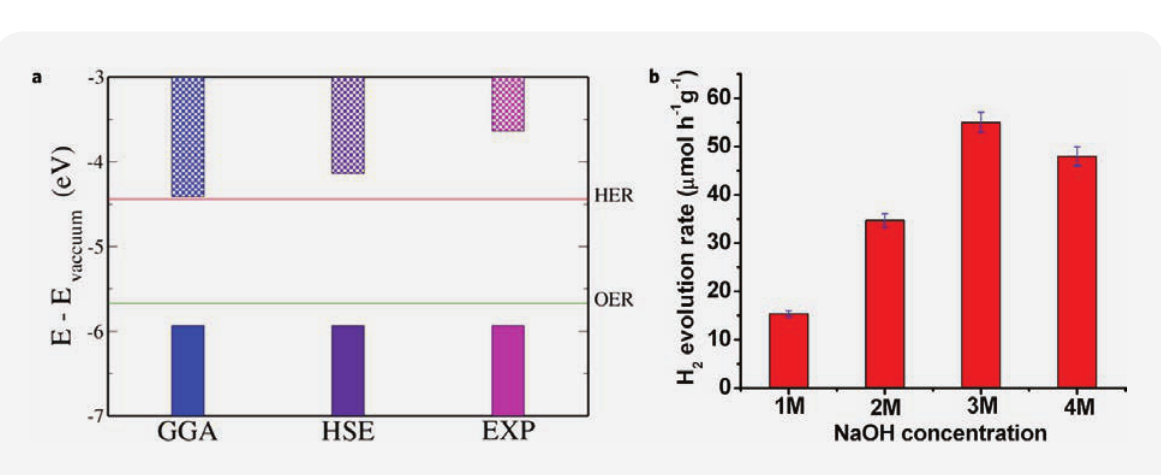
Figure 7. (a) Band edge positions obtained from fi rst-principles calculations relative to water reduction and oxidation potentials and (b) variation of hydrogen evolution activity with NaOH concentration on Cd 4 P 2 Cl 3 . Reproduced with permission from Ref.